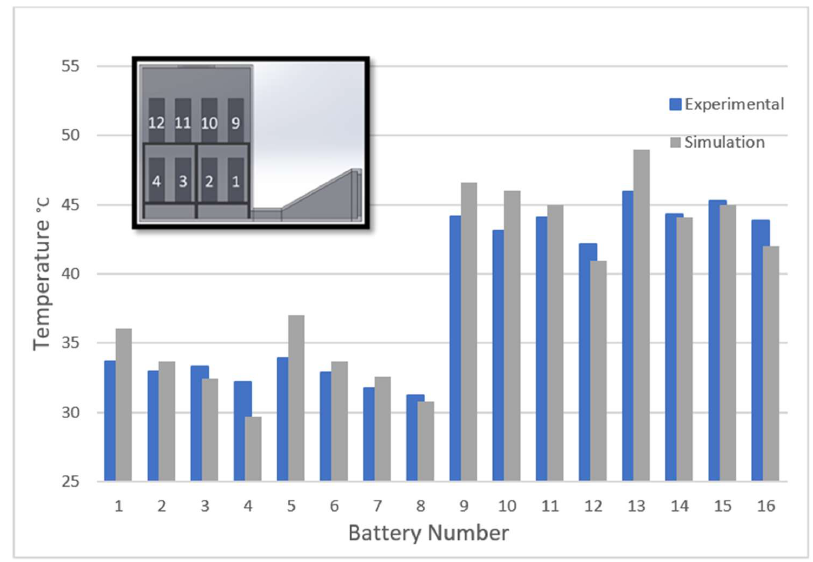
Figure 14. Comparison of experimental steady state temperatures against the simulation temperatures for the vented design.